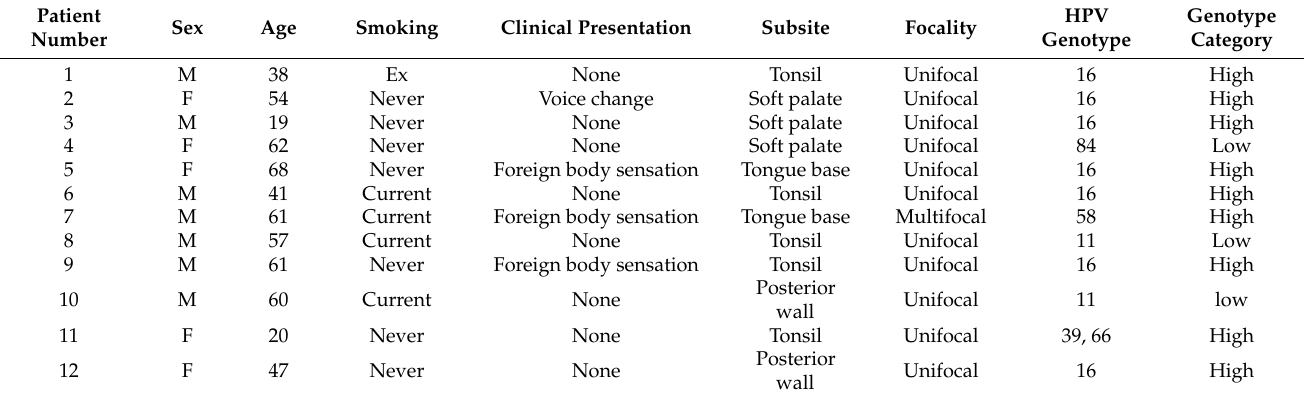
Table 3. Detailed characteristics of 12 patients with HPV-positive oropharyngeal squamous cell